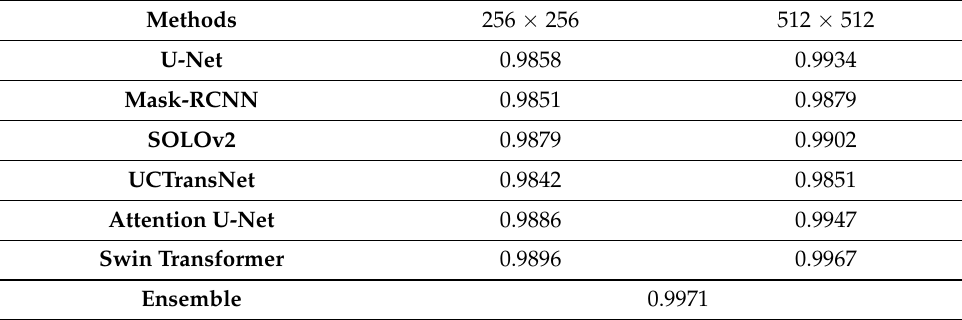
Table 3. Pixel accuracy for different neural network